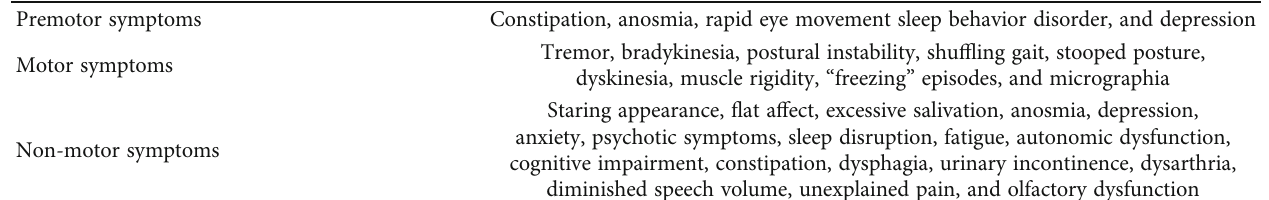
Table 1: Parkinson ’ s disease symptomatology (adapted from Kalia et al. (2015) [5] and Zesiewicz (2019) [1]). Premotor